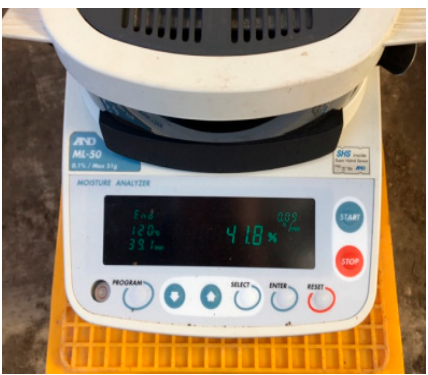
Figure 11. Moisture content of the livestock manure dried by the screw-type dryer.